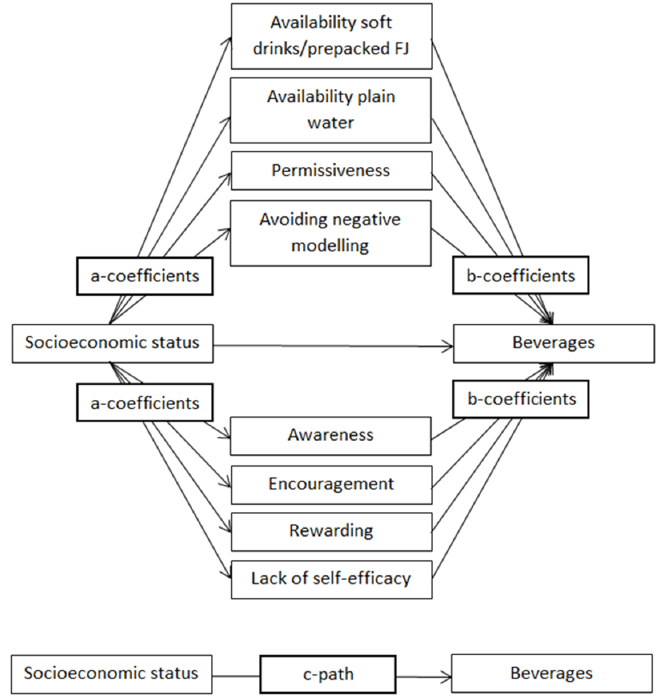
Figure 1. Mediation model of the association between socioeconomic status, parenting practices and beverage intake.